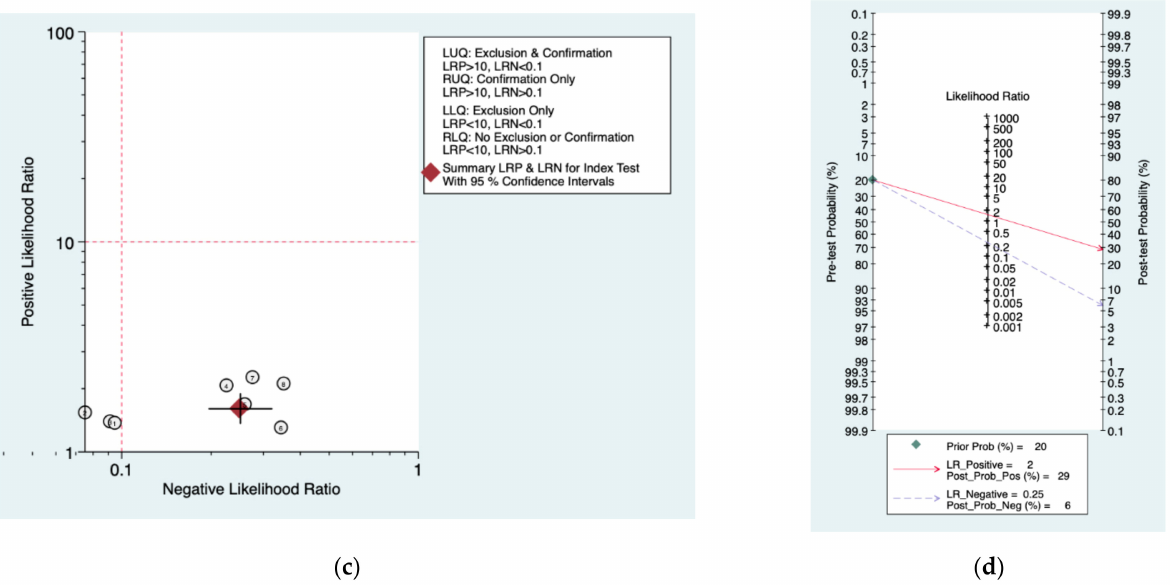
Figure 4. Meta‑analysis of Department of Health protocol. ( a ) Forrest plot of pooled sensitivity and specificity [8,10,22–25]; ( b ) Hierarchical summary receiver operating characteristic (HSROC) curve; ( c ) Likelihood ratio scattergram; ( d ) Fagan nomogram.